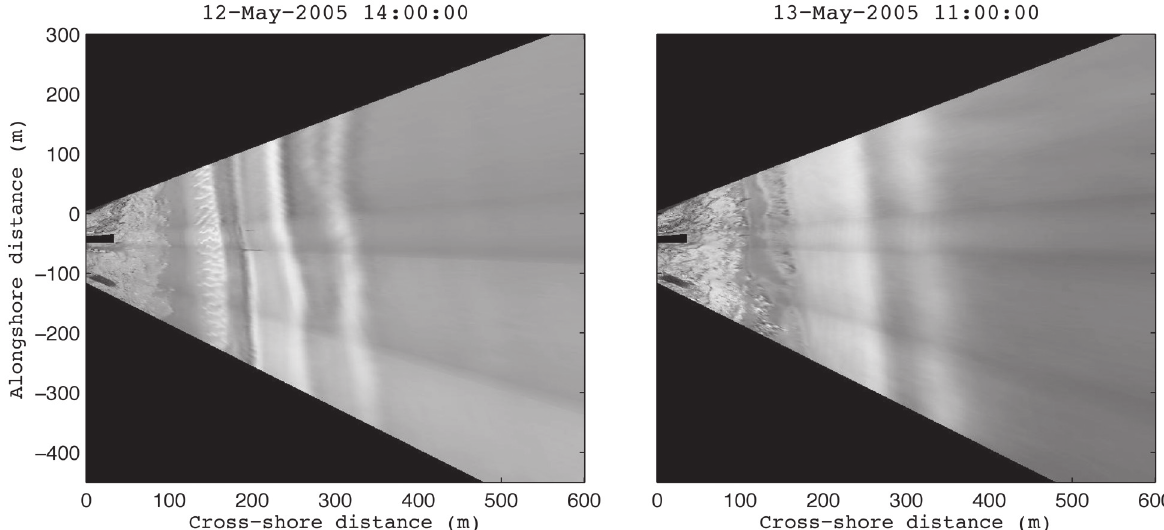
Figure 10 - At the left image it is possible to observe sand dunes at the backshore; at the right is an image captured on the day after the one in the left with the water and waves overtopping the ephemeral dunes, and consequently eroding